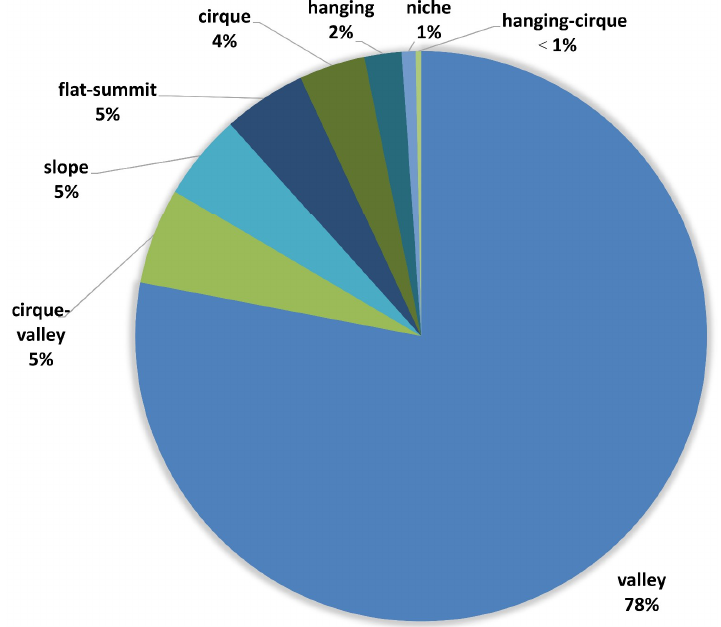
Figure 11. Distribution of glacial areas in the LIA by morphological types.